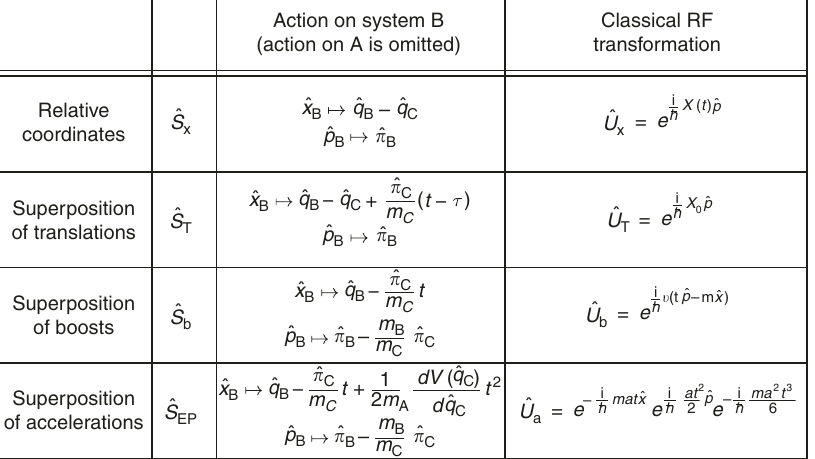
Fig. 4 Table summarising different quantum reference frame (QRF) transformations on system B. (The action on A is omitted) The time-independent transformation ^ S is the QRF generalisation of a standard reference frame (RF) transformation where the reference frame is moving along X ( t ), and the x relative coordinates describe the distance between systems A and B at time t . The three QRF transformations ^ S , ^ S , and ^ S generalise the extended T b EP Galilean transformations to a reference frame which is respectively translated, moving with constant and uniform velocity, and moving with constant and uniform acceleration. In particular, ^ S transforms the old coordinate x into the relative position between system B at time t and system A at time τ , and T B reduces to ^ S for t ¼ τ . The transformation ^ S performs a Lorentz boost on system B, where the velocity is written in terms of dynamical variables of x b system A. Finally, the transformation ^ S EP , generalises the transformation to an accelerated reference frame to when system A moves in a superposition of accelerations. Importantly, the extension of the RF transformation to dynamical quantities of quantum systems makes it possible to introduce a generalised notion of symmetric transformation, which is exempli fi ed, in this work, in the case of the ^ S and ^ S T b